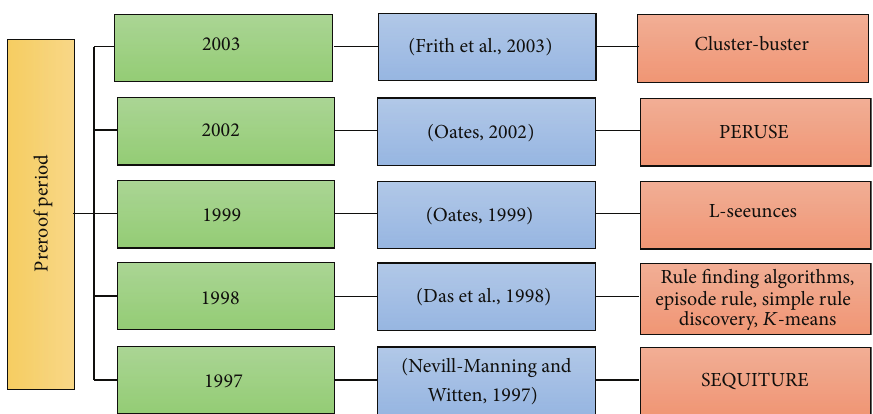
Figure 5: The chronology of methods in preproof